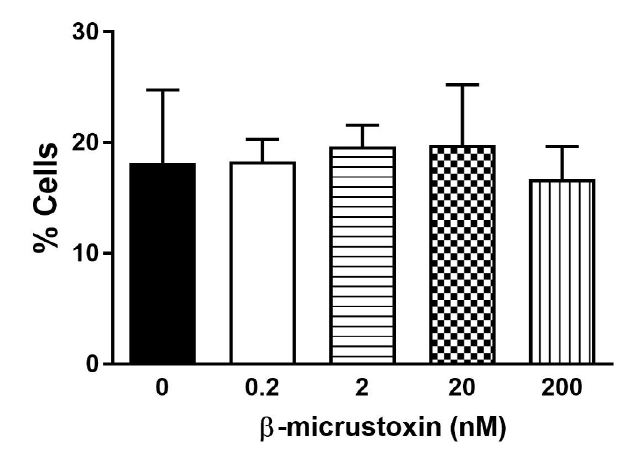
Figure 7. DNA fragmentation expressed by sub-G1 population of astrocytes incubated in the absence (control) or presence of β-micrustoxin (0.2, 2, 20, 200 nM) for 24 h and evaluated by flow cytometry. One-way ANOVA, p>0.05. N =